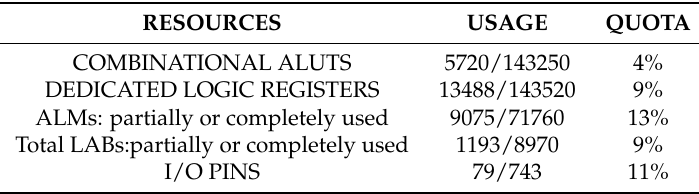
Table 1. ALTERA Stratix II EP2S180 FPGA Resources